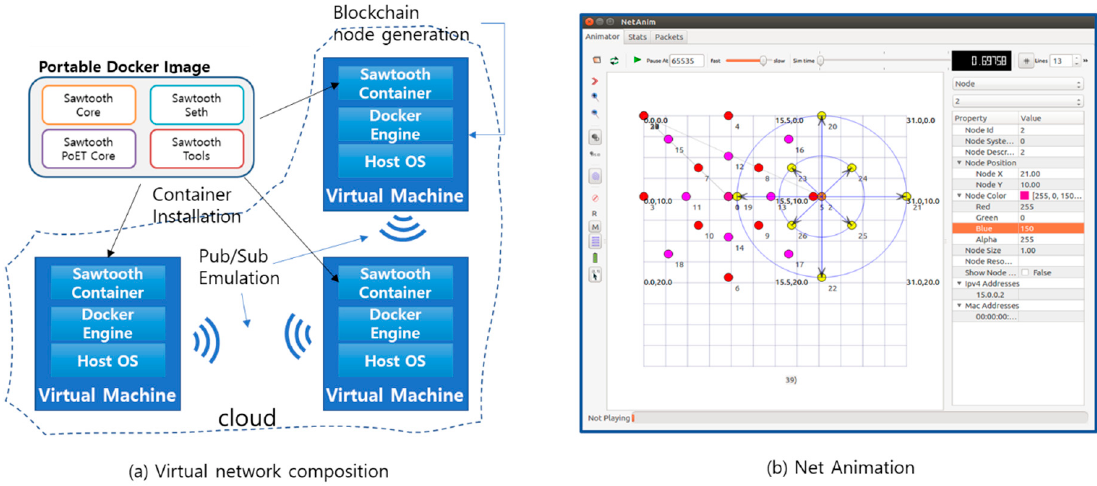
Figure 6. Blockchain node generation in cloud and visualization of network structure.